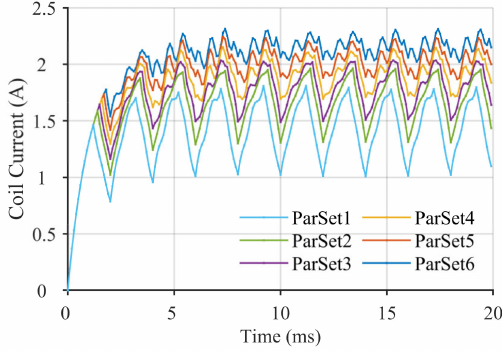
Figure 12. Dynamic current responses of coil in an LSV.